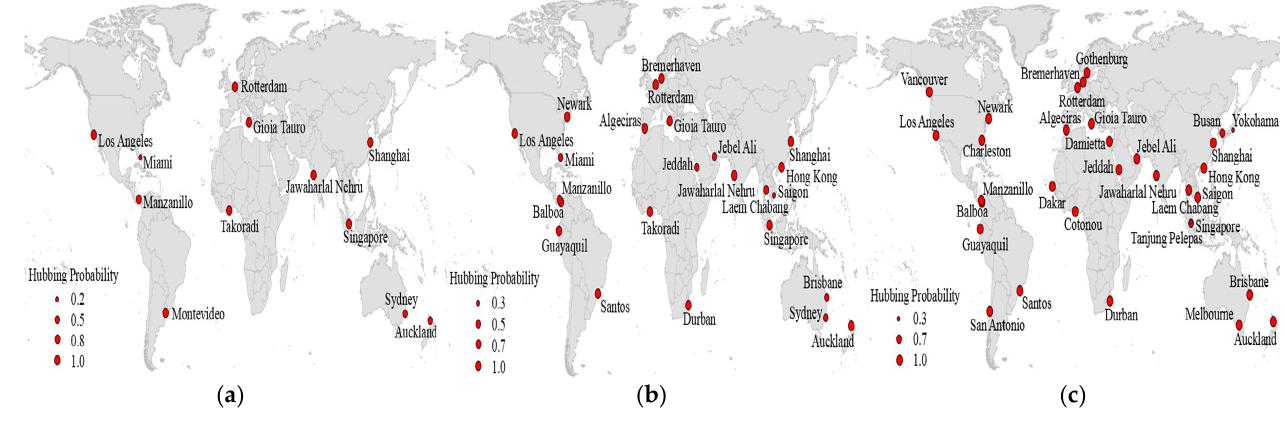
Figure 4. Hubbing probabilities for each port in each community. ( a ) p = 1, ( b ) p = 2, ( c ) p =